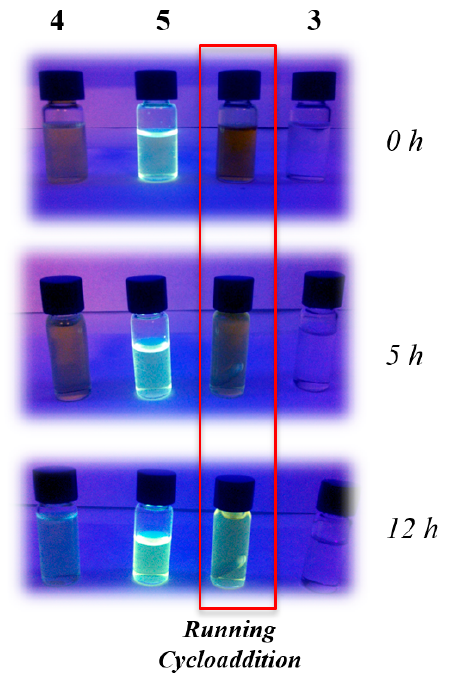
Figure 1. Fluorescence properties of reagents 3 and 4 and cycloadduct 5